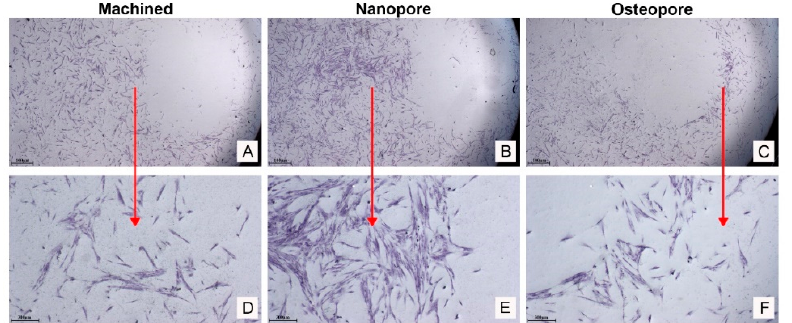
Figure 5. Osteoblasts differently interacted with Ti discs. The enrichment in calcium and phosphorus promoted the interaction between primary osteoblasts and Nanopore surface at late stage of proliferation (5 days). Images were taken by an inverted microscope connected with a camera at the magnification of 6 × ( A – C ) and 25 × ( D – F ). The red arrows indicate the magnification of cell images (Scale bar: 100 µ m at low magnification and 300 µ m at higher